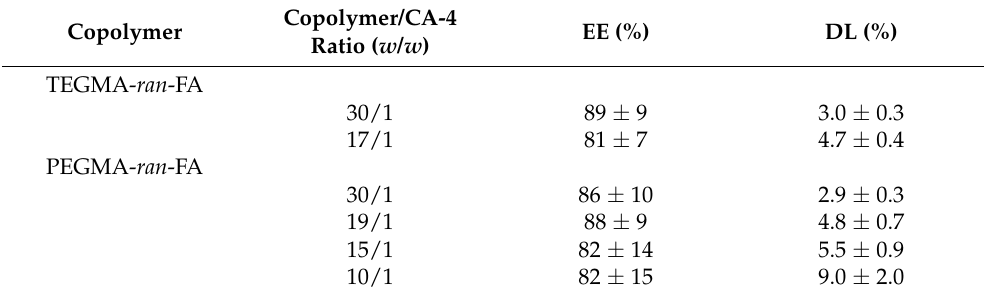
Table 3. Encapsulation efficiency (EE) and drug loading (DL) data for Combretastatin A-4 encapsu- lated in the amphiphilic random copolymers at room temperature.